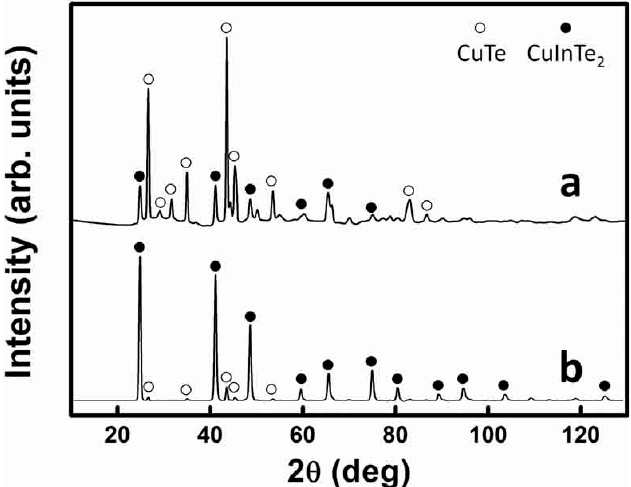
Figure 8. XRD of when the CuInTe 2 nanocrystals reaction was taken: ( a ) 5 min; and ( b ) 10 min. (CuTe: portable document format (PDF) No. 26-0524 and CuInTe 2 : PDF No. 43-1401).